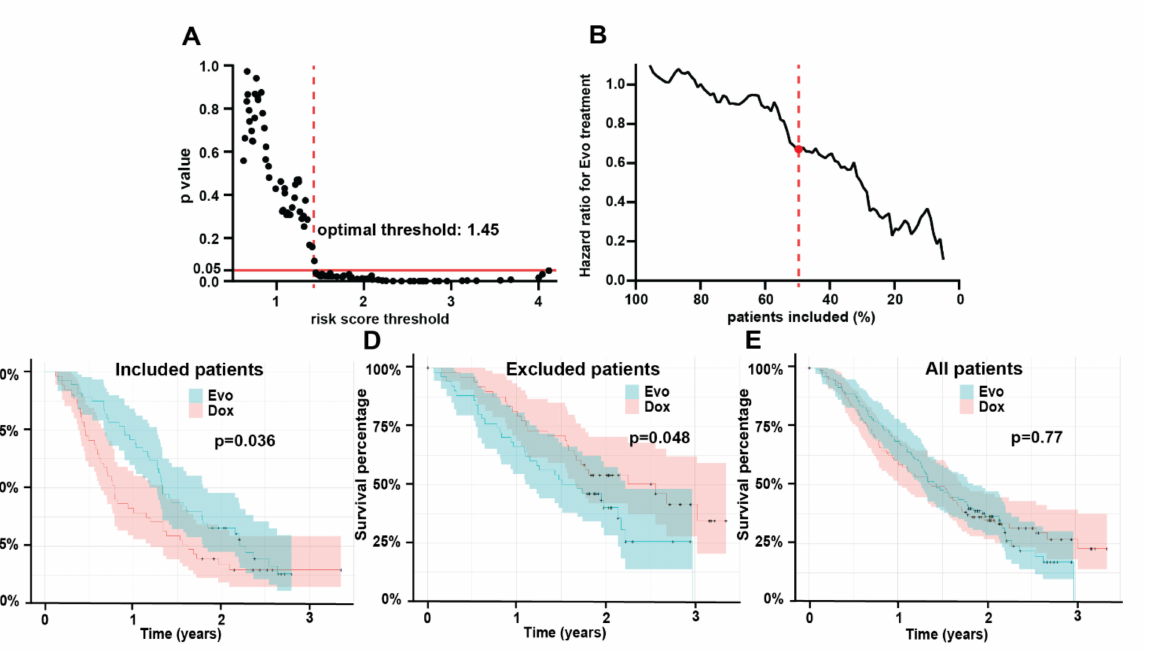
Figure 1. Patient inclusion model. Patient selection into the trial based on Dox group survival was executed according to the following method: firstly ( 1 ) radiomic and clinical features associated in training cohort with survival in Dox but not Dox + Evo treatment group were included in a multivariable Cox regression model ( 2 ), trained on Dox treated patients. The risk score assigned by the model to each training set patient was then used as a biomarker for inclusion into analysis, iteratively calculating the p -value and hazard ratio for survival comparison between treatment arms depending on minimum risk score threshold ( 3 ). If available, threshold corresponding to significant ( p -value < 0.05) treatment benefit of Dox + Evo at highest percentage of patients included was chosen ( 4 ), and subsequently tested in the test cohort ( 5 ), with risk scores assigned by the multivariable Cox model developed in step ( 2 ). A corresponding model can also be developed based on Dox + Evo group survival, using a maximum risk score threshold.